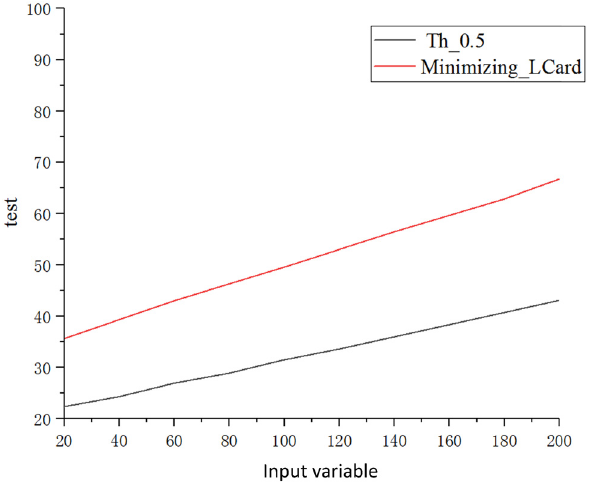
Figure 2: Comparison of the retrieval cost of Minimizing_LCard and th_0.5 on the test